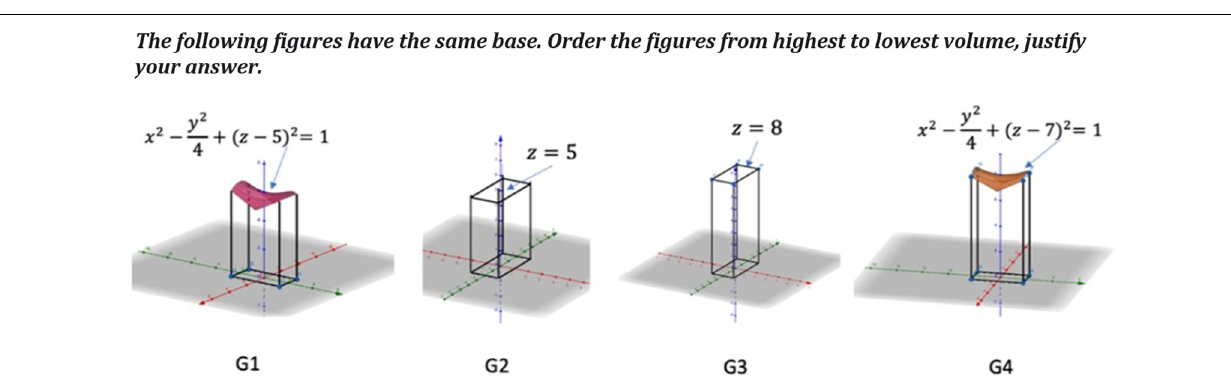
approximately 15 min to answer each test in the